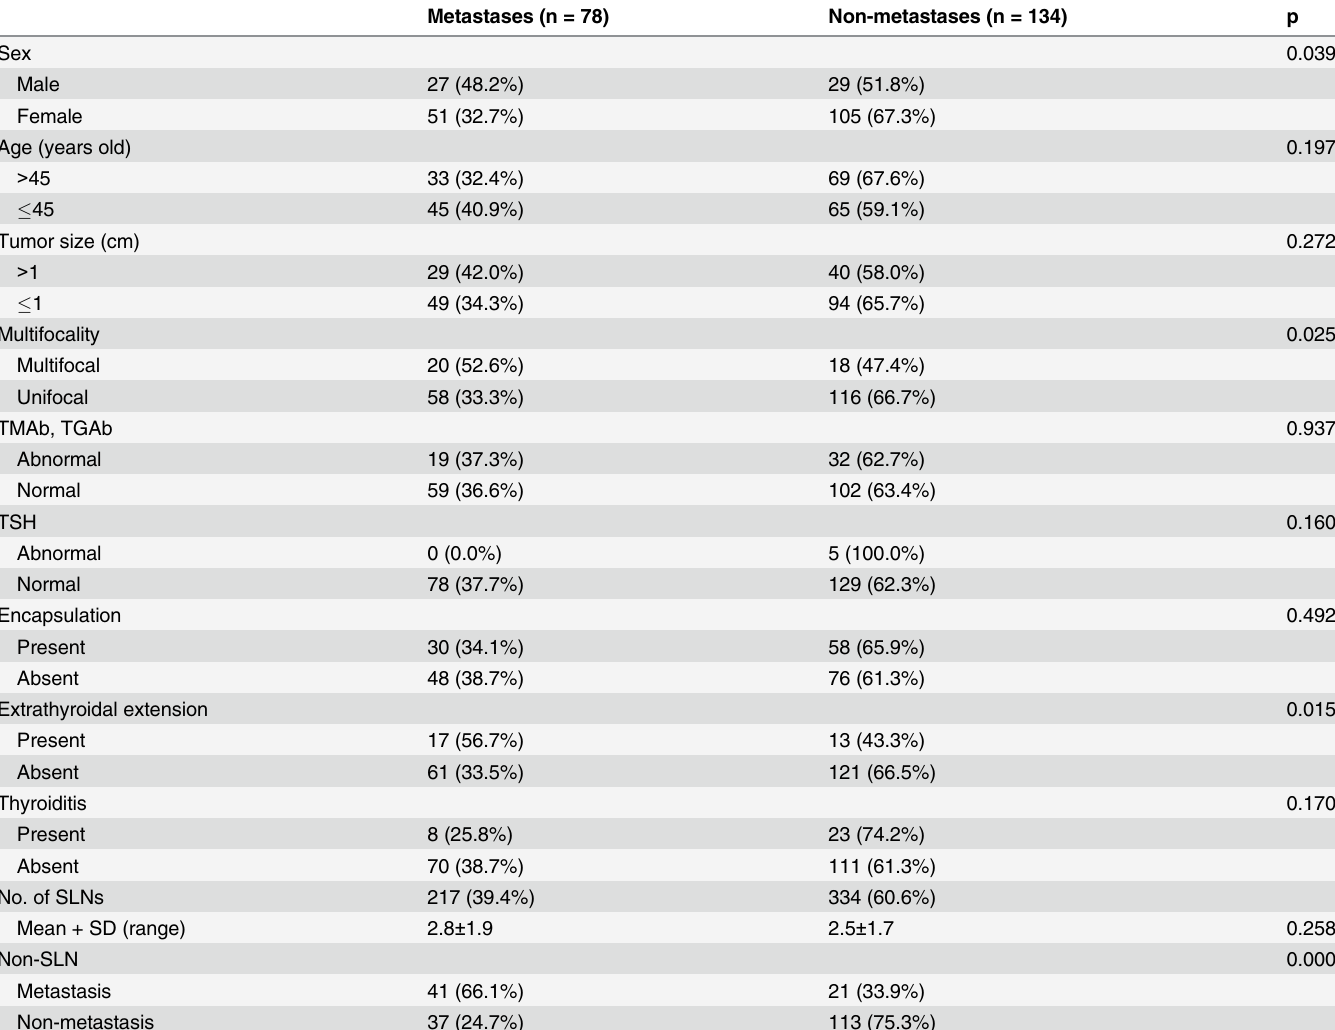
Table 3. Comparison of patients with and without SLN metastasis (n = 212).